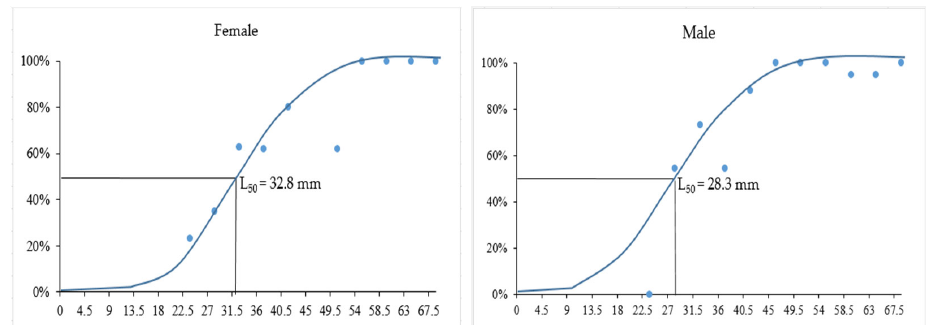
Figure 9. Percentage of mature individuals and the total shell length (SL) for females and males of Saccostrea cucullata from Inhaca Island.